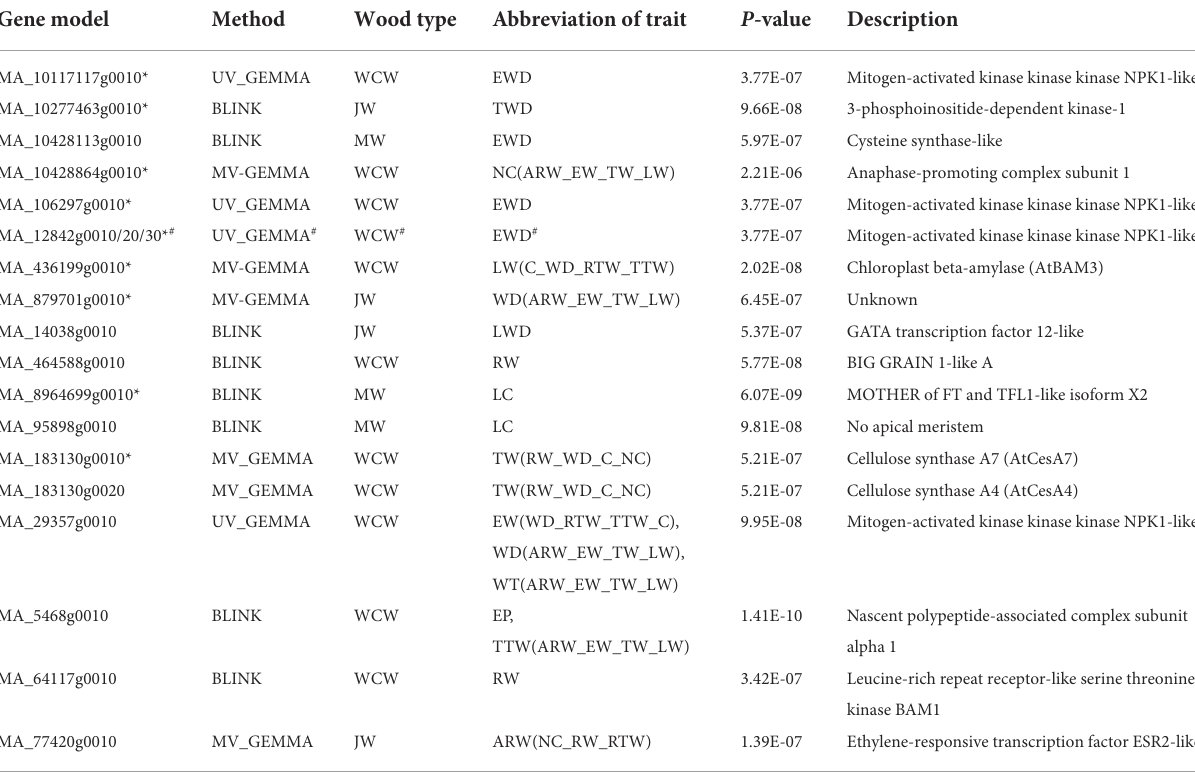
TABLE 3 A selection of genes with significant SNPs associated with different traits in juvenile, mature, and whole core wood in the three different types of GWAS analyses. Gene model Method Wood type Abbreviation of trait P -value Description